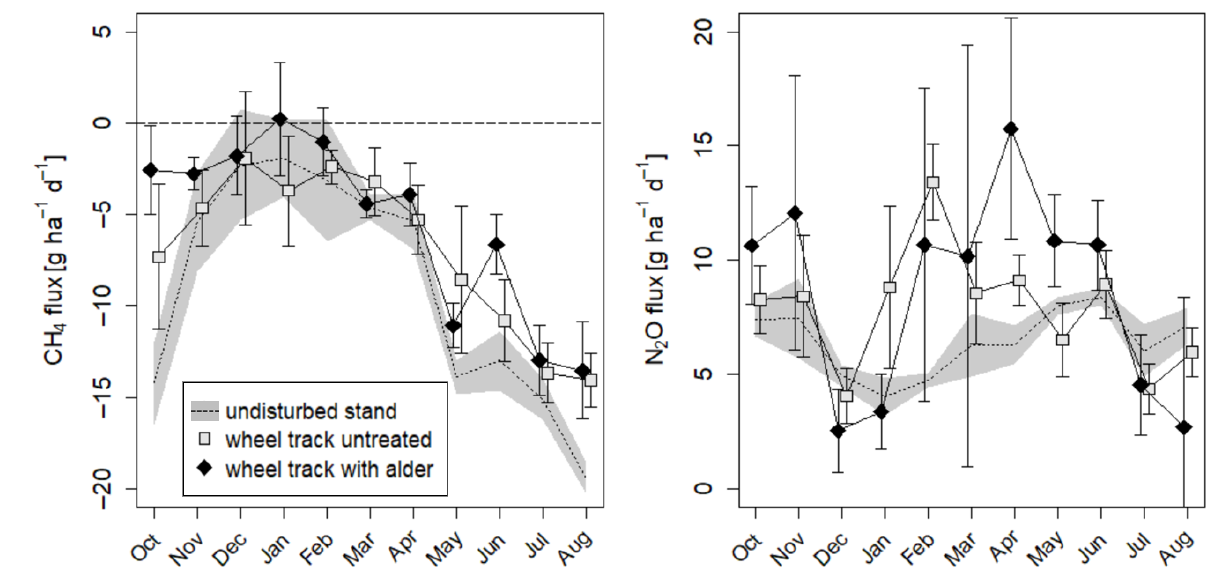
Figure 5. Medians of monthly N 2 O and CH 4 flux measurements in the undisturbed beech stand (dashed line) and on wheel tracks 10 years after soil trafficking (2017/18). The grey shading and error bars indicate the 95% confidence intervals of median values. Table 2. Median values of cumulative CO 2 , N 2 O and CH 4 fluxes and their 95% confidence interval. Different letters indicate significant differences between